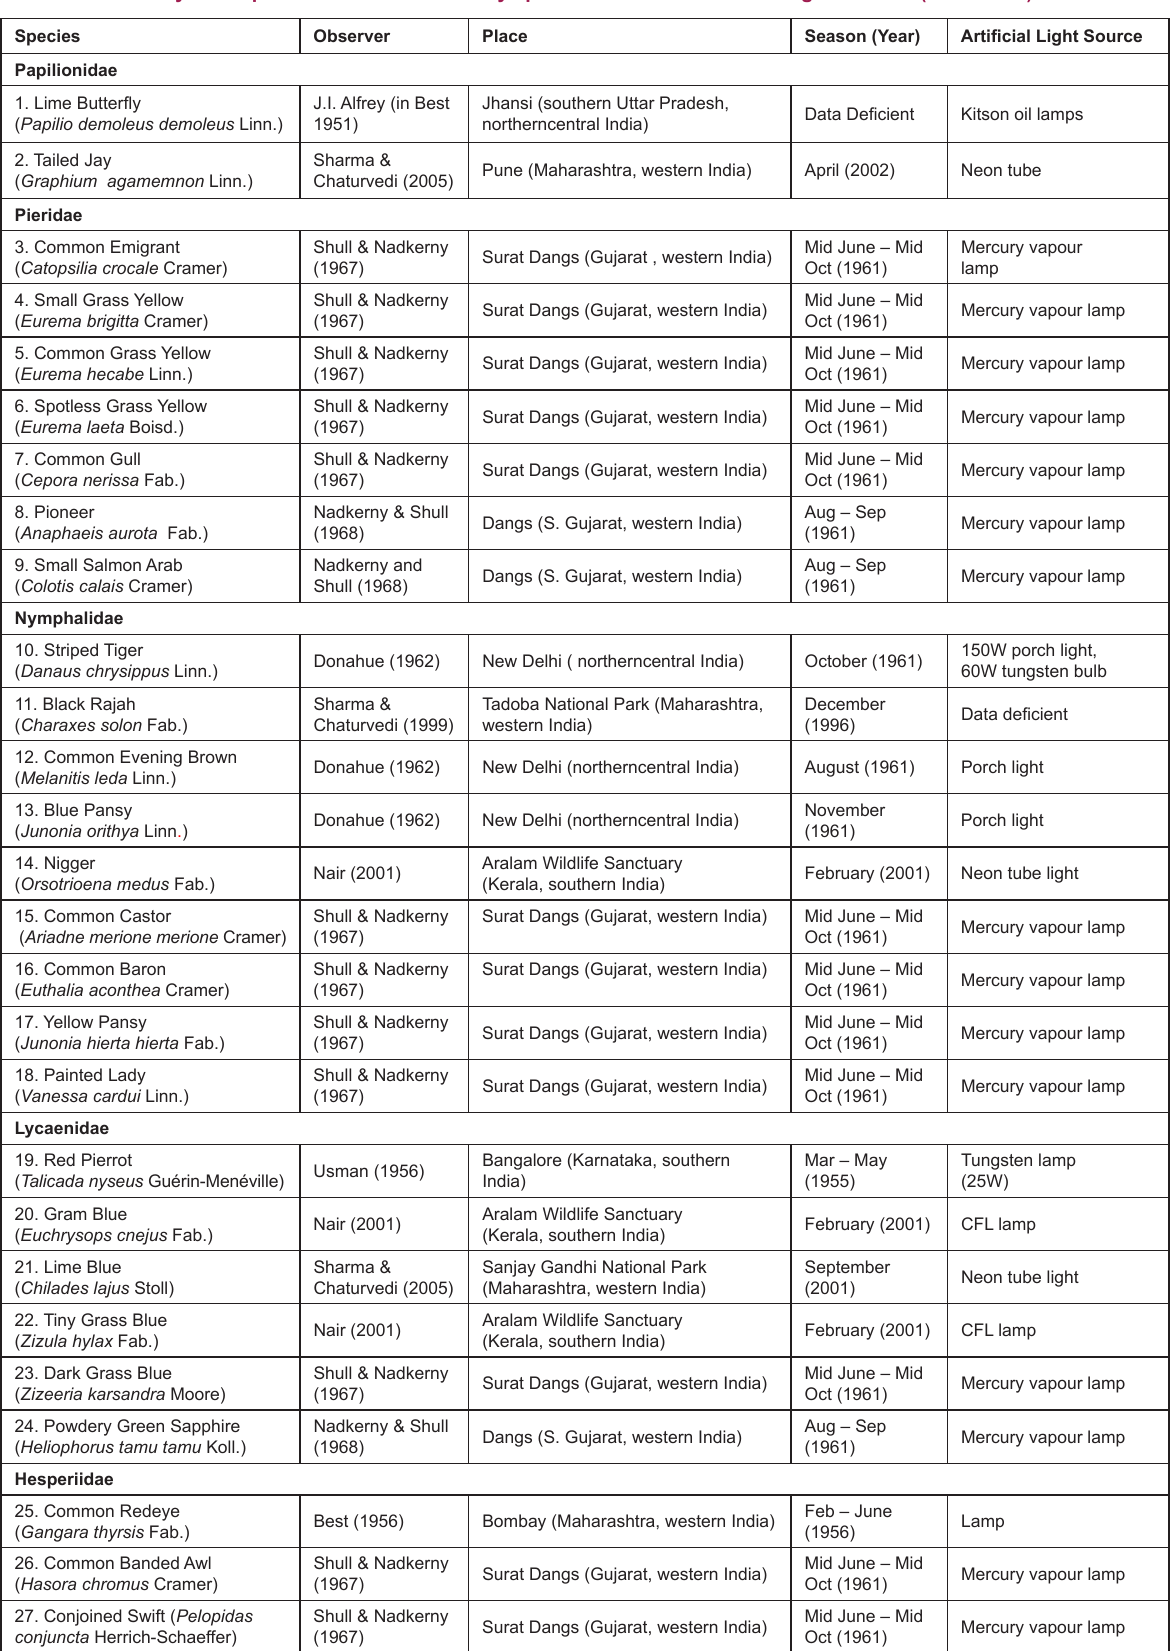
Table 1. A summary of the published data on butterfly species attracted to artificial light sources (1951–2005). Species Observer Place Season (Year) Artificial Light